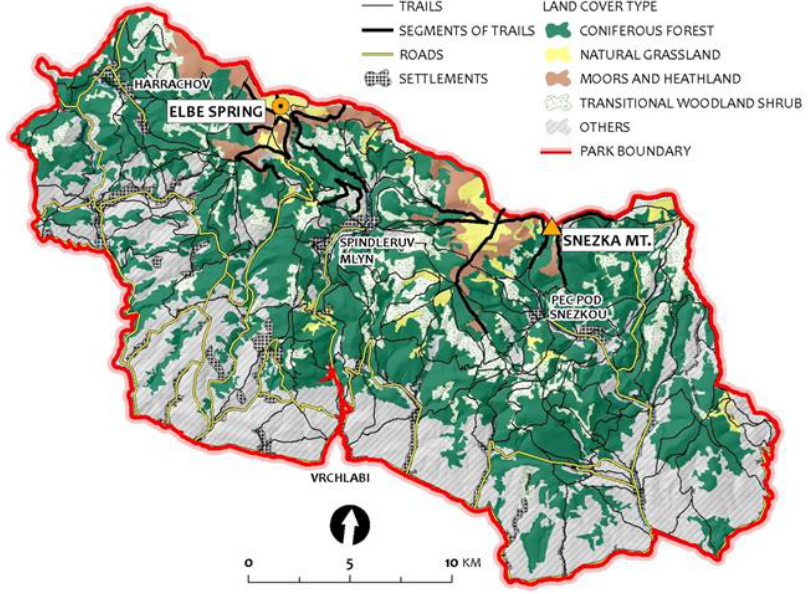
Fig. 3. Location of assessed trail segments within Krkonoše Mountains National